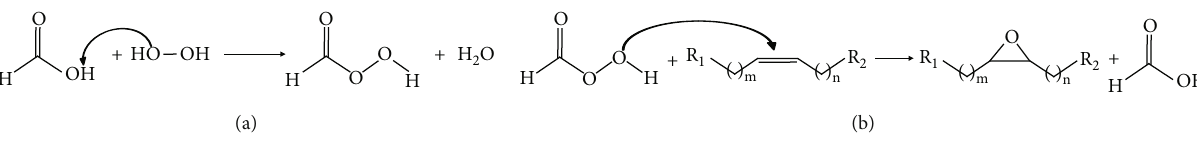
Figure 1: Conventional epoxidation process with formic acid and hydrogen peroxide